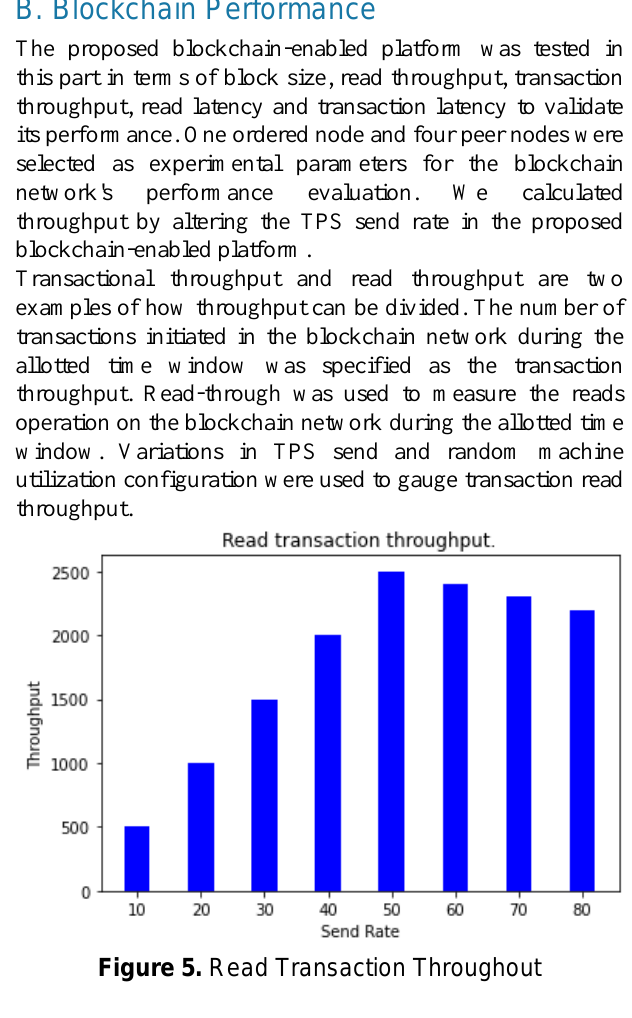
Figure 6. Transaction Throughout Performance of Machine Learning Models for Security Prediction